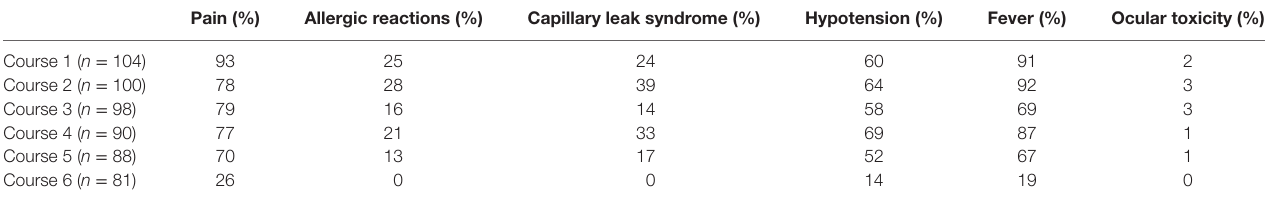
TaBlE 3 | Proportion of patients with Grades 1–5 toxicities attributed to ch14.18 on COG study ANBL0931.